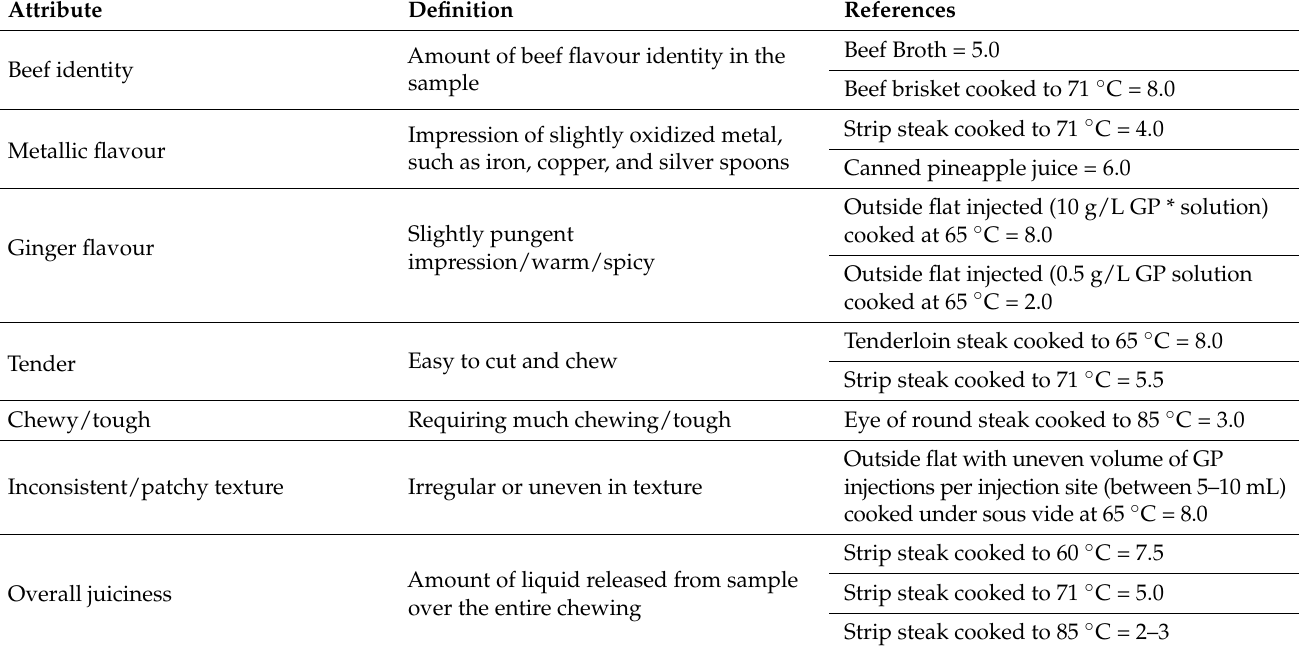
Table 1. Selected beef attributes, description, and reference samples used to train the sensory panelists.